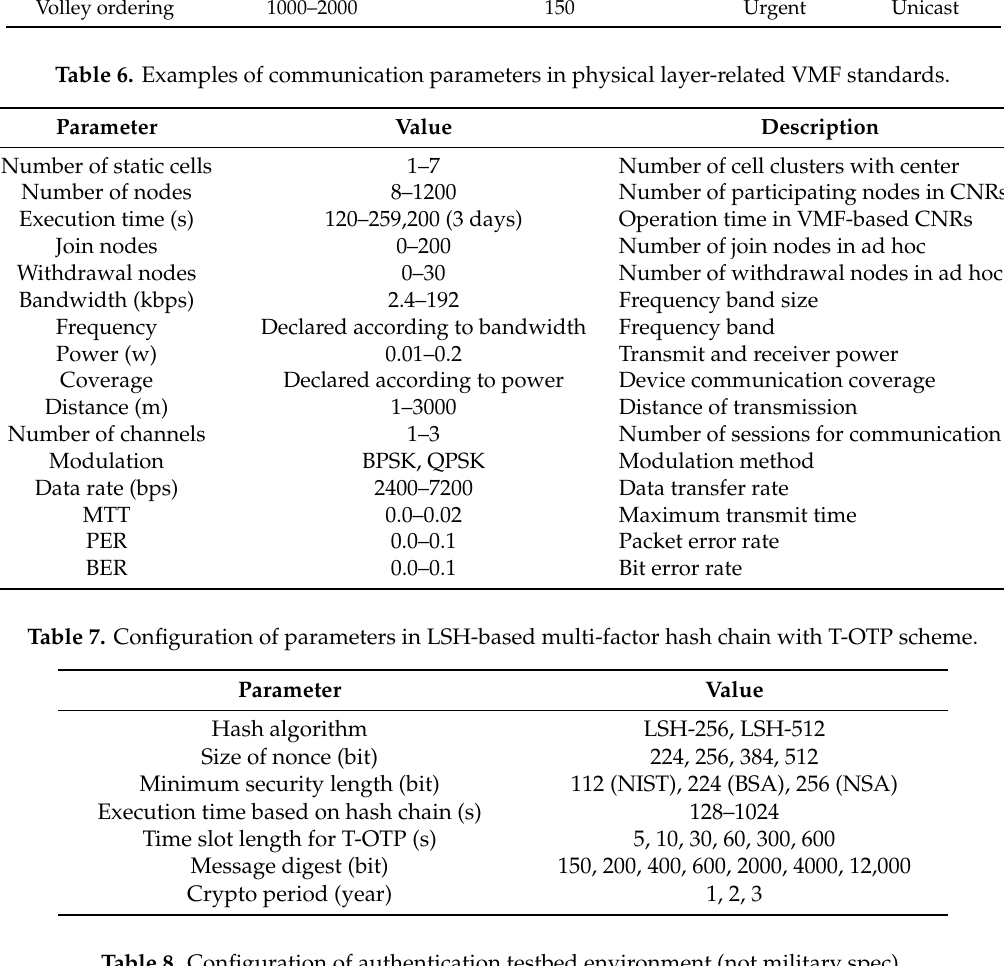
Table 8. Configuration of authentication testbed environment (not military